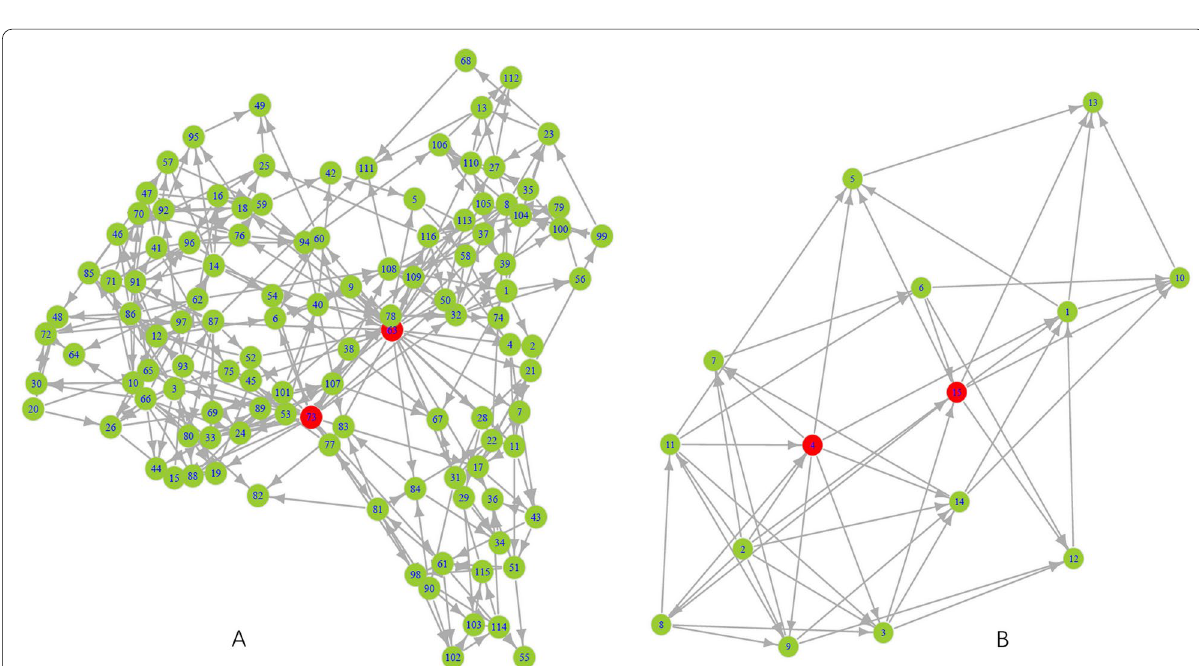
Fig. 4 The gene regulatory network by Bayesian networks in A group 7 of C. sativus and B group 10 of B.